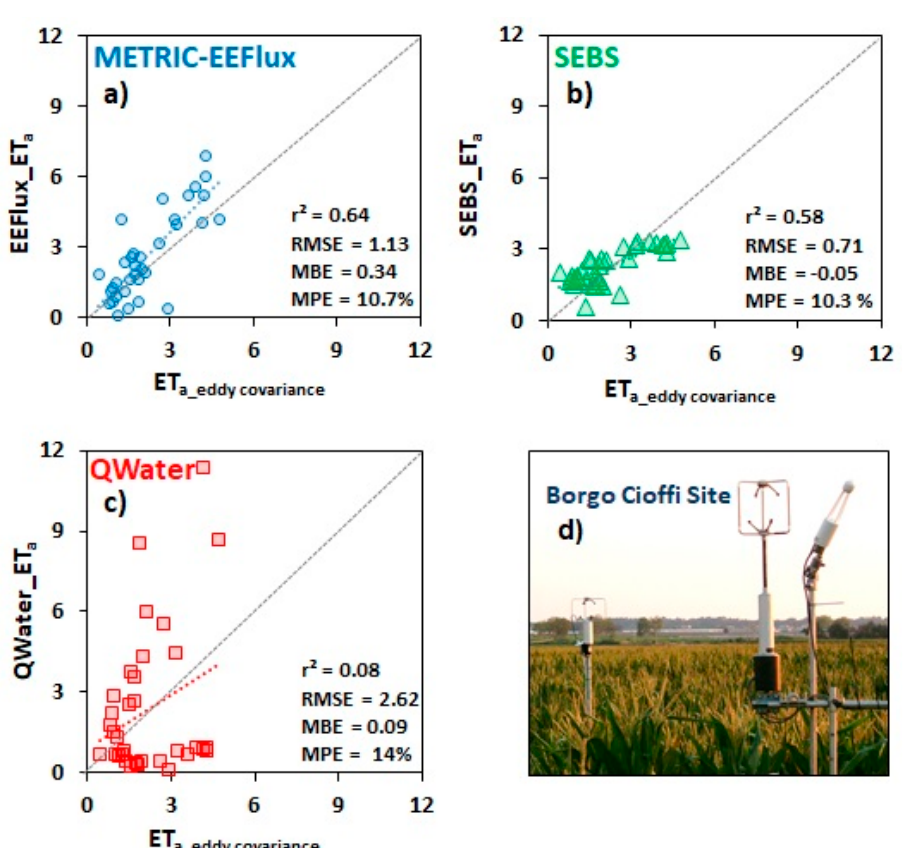
Figure 6. Comparison of model based ET a time-series (in bars) with measured ET a (in black dotted line) to present single-source models’ performance under the field scenario of IT_BCi Buffalo Farm in the Mediterranean climate. X -axis belongs to the image acquisition dates covering a two-year span of a rotational cropping system (2008–2009).